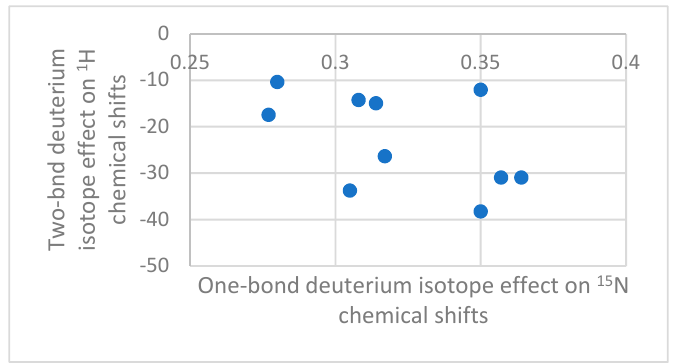
Figure 8. A plot of 2 Δ H(D) vs. 1 Δ N(D). Data from Ref. [26].